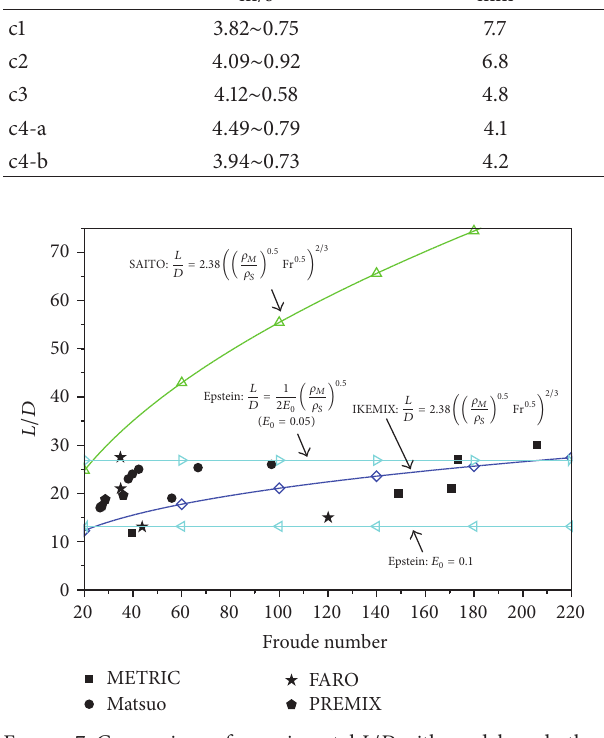
Figure 7: Comparison of experimental L / D with models and other